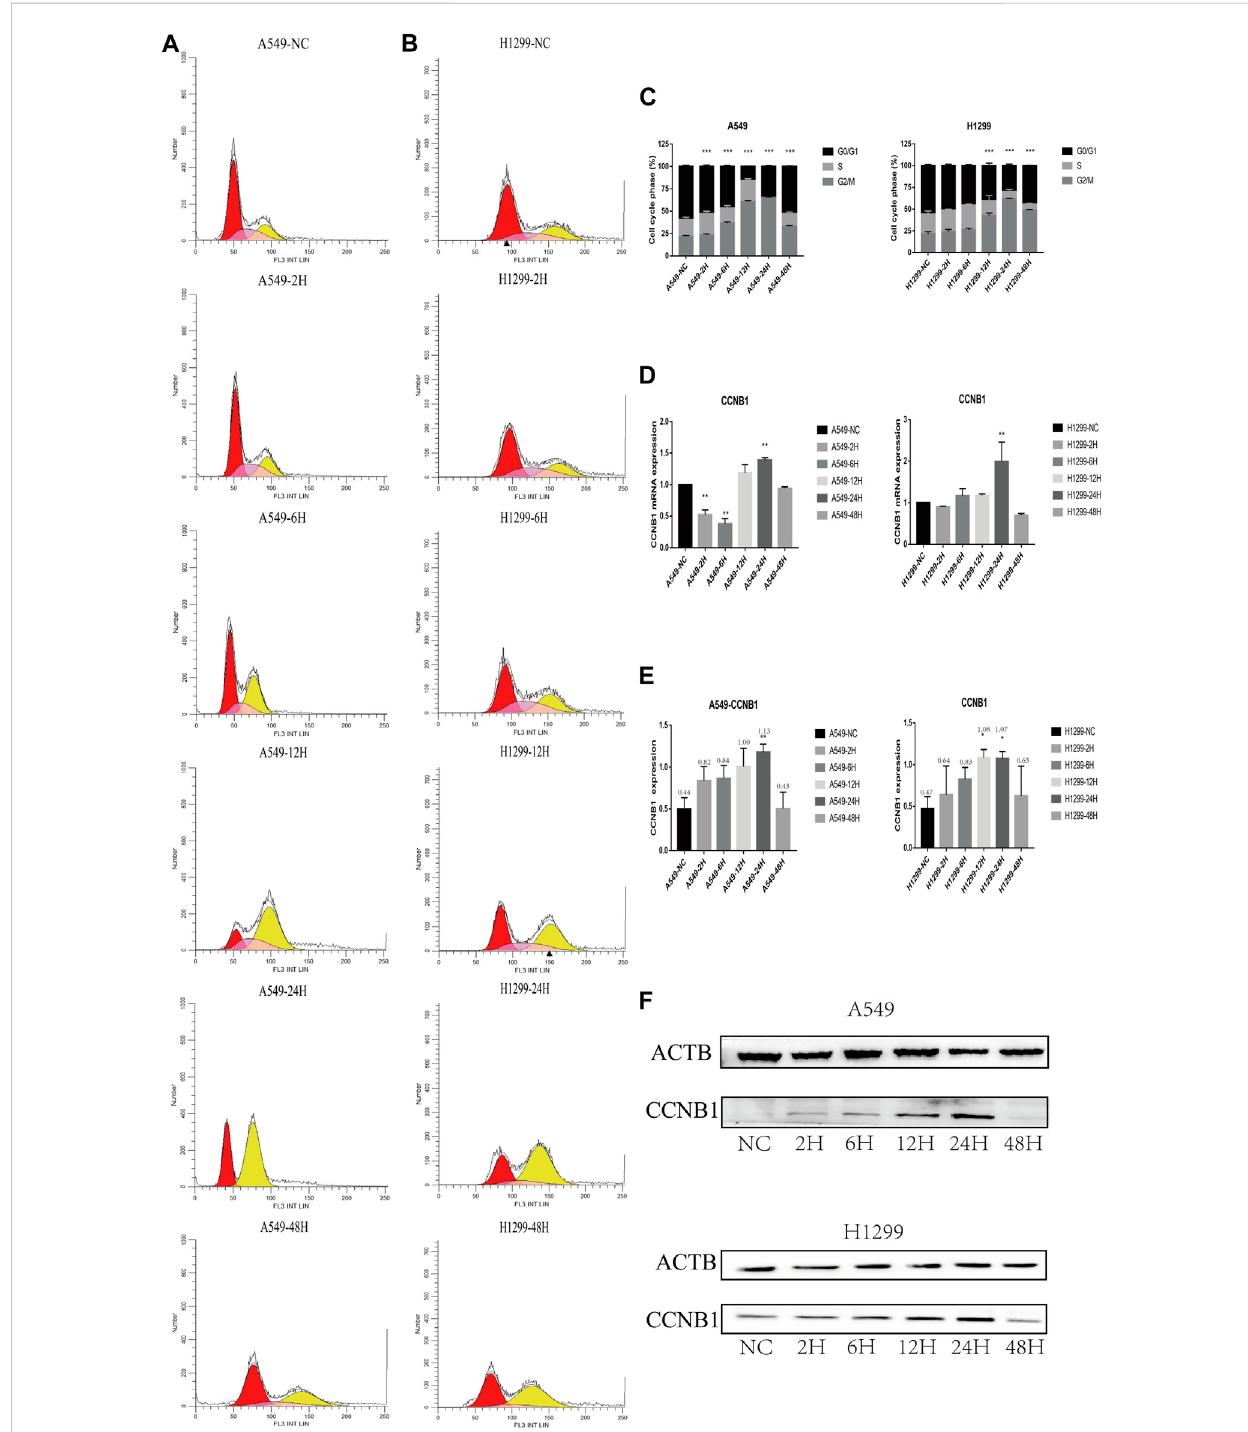
FIGURE 5 Cell cycle and cell cycle-related protein expression after radiation in NSCLC cells. * p < 0.05, ** p < 0.01, and *** p < 0.001. (A) Cell cycle analysis of A549at2,6,12,24,and48 hafterradiation. (B) CellcycleanalysisofH1299at2,6,12,24,and48 hafterradiation. (C) Statisticalanalysisofdifferentphases of the cell cycle at 2, 6, 12, 24, and 48 h after radiation in A549 and H1299 cell lines. (D) PCR statistical results of CCNB1 at 2, 6, 12, 24, and 48 h after radiation in A549 and H1299 cell lines. (E) Western blot statistical results of cyclin B1 at 2, 6, 12, 24, and 48 h after radiation in A549 and H1299 cell lines (quantitative data are shown as means). (F) Western blot results of cyclin B1 at 2, 6, 12, 24, and 48 h after radiation in A549 and H1299 cell lines, compared with the non-radiation control